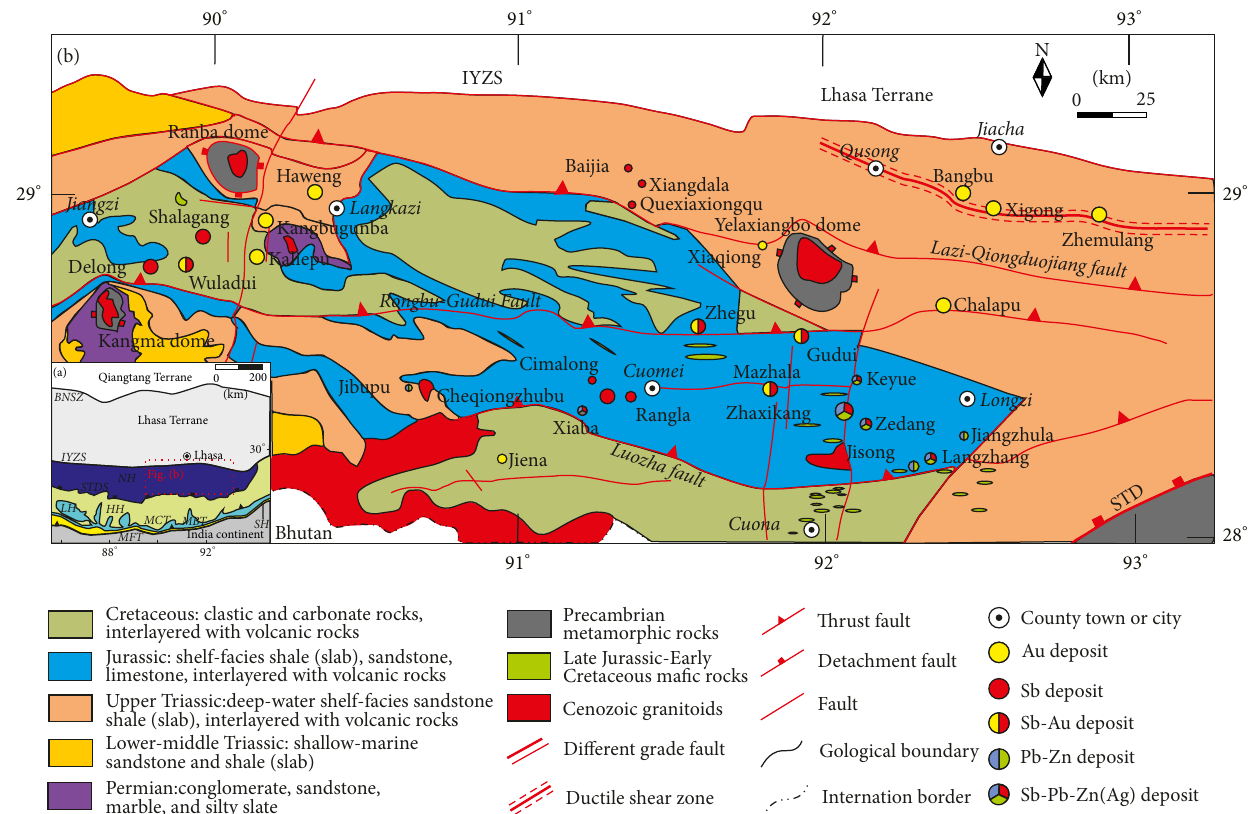
Figure 1: (a) Tectonic framework of the Himalayan Terrane (modified from Yin [24]). (b) Regional geological map of the North Himalayan Polymetallic Metallogenic Belt (modified from Zheng et al. [25]). BNSZ: the Bangong-Nujiang Suture Zone; IYZS: the Indus-Yarlung Zangbo Suture Zone; STDS: the South Tibet Detachment System; MCT: the Main Central Thrust Fault; MBT: the Main Boundary Thrust Fault; MFT: the Main Frontal Thrust; NH: the North Himalayan Tethys Sedimentary Fold Belt; HH: the High Himalayan Crystalline Rock Belt; LH: the Low Himalayan Fold Belt; SH: the Sub-Himalayan Tectonic